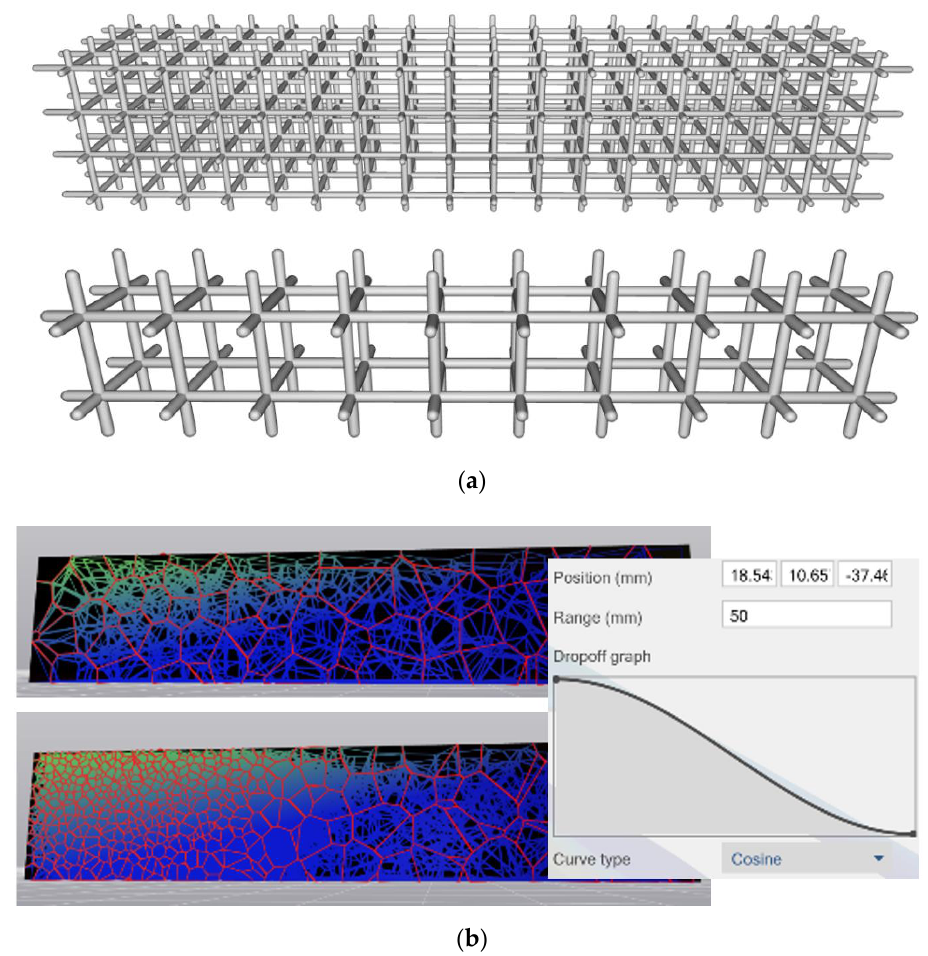
Figure 3. Cells can be distributed in a prescriptive manner, ( a ) shown for a periodic lattice, or ( b ) by using a function, shown for a stochastic lattice.